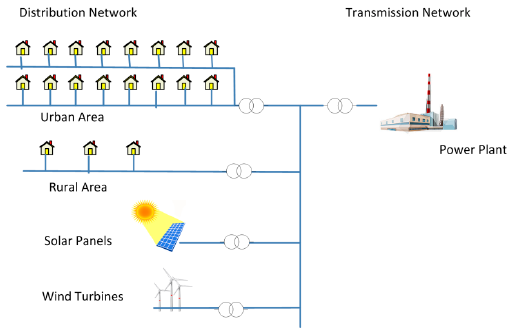
Table 8. Summary of projects for Renewable Energy Sources—Integration and Monitoring.